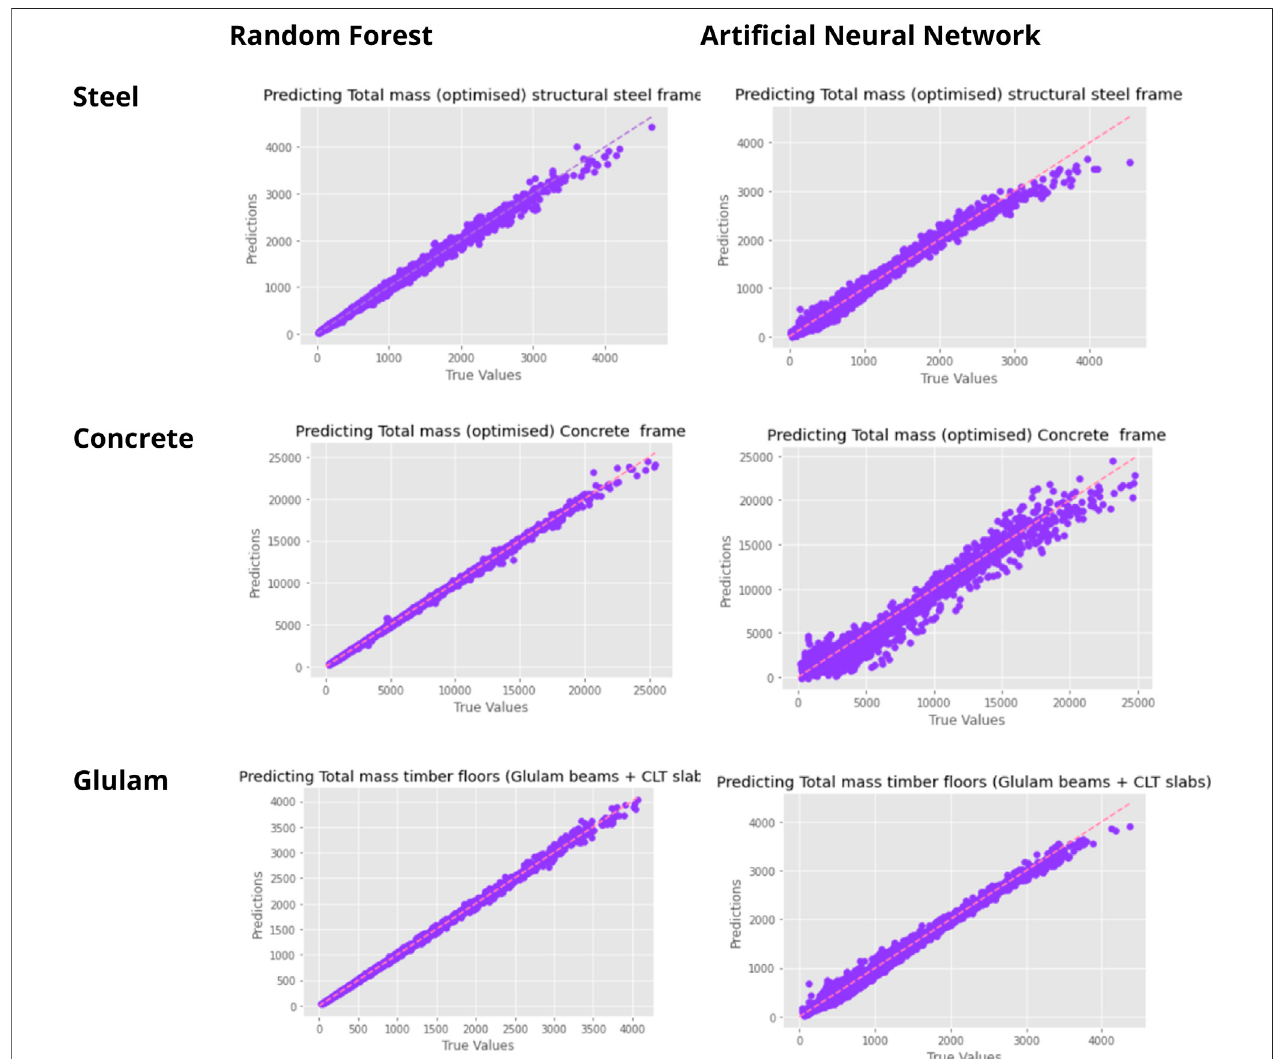
FIGURE 2 | Actual vs predicted plots for total mass for each of the three materials.